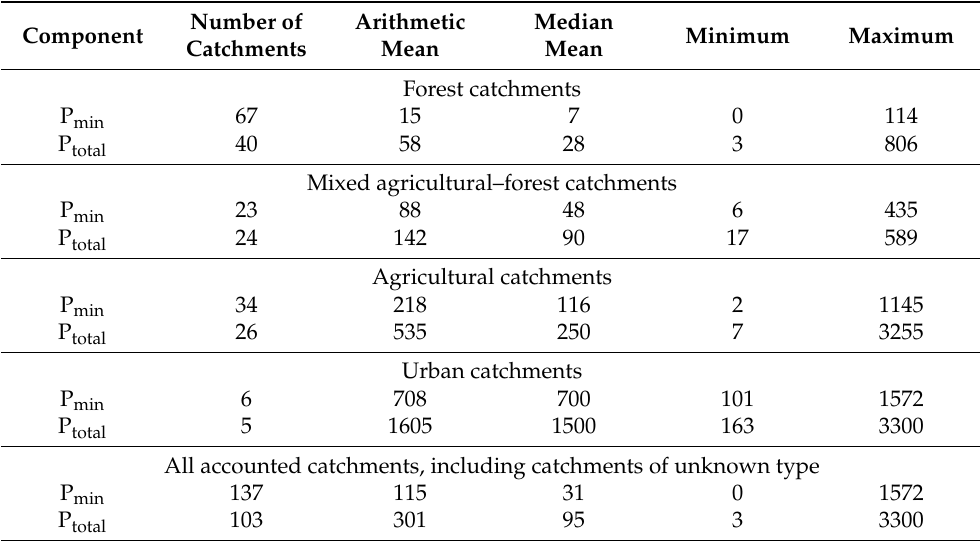
Table 9. The average content and concentration range of dissolved phosphorus ( µ g/L) in the waters of the primary hydrographic network